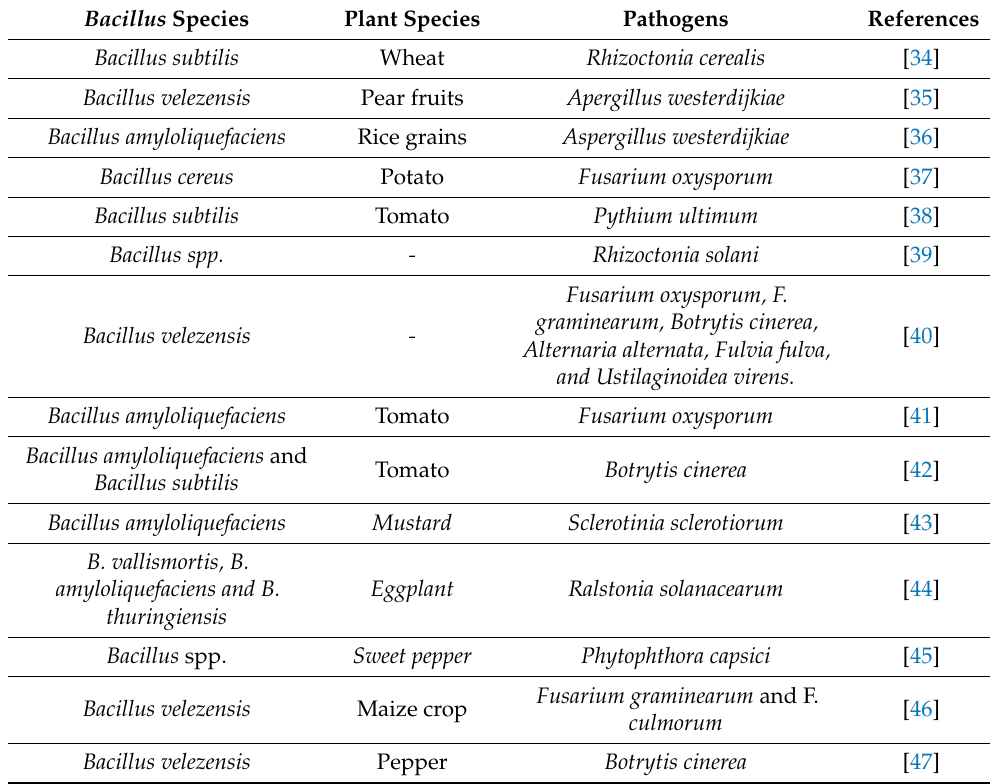
Table 1. Bacillus species were reported as biocontrol agents against various phytopathogens. Bacillus Species Plant